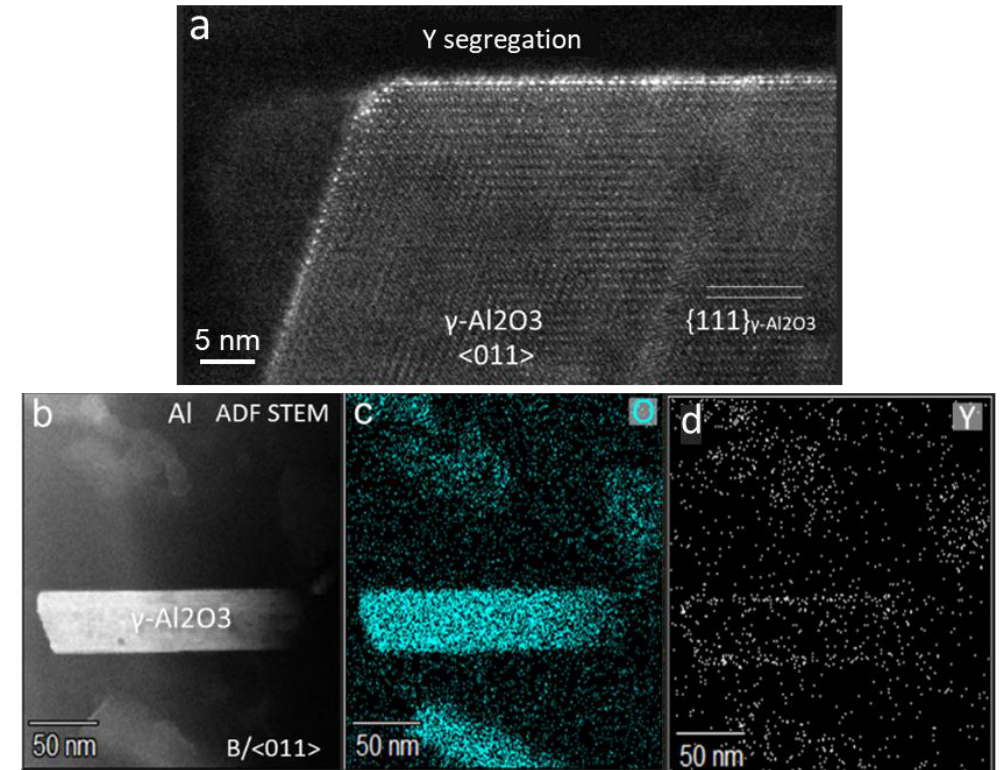
Figure 34. Y segregation at Al/γ -Al 2 O 3 interface. ( a ) STEM- HAADF image of Al/γ -Al 2 O 3 interface for a γ -Al 2 O 3 particle in Al-0.075Y alloy; ( b ) STEM ADF image; and EDS elemental mapping of ( c ) O and ( d ) Y, showing Y enrichment at the interface.